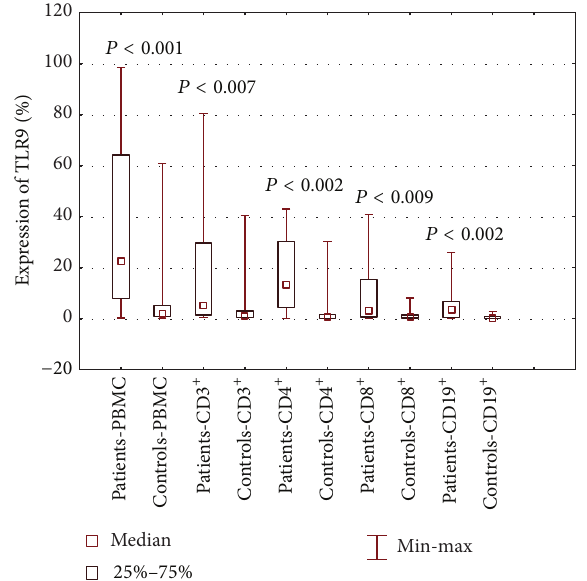
Figure 3: The percentage of PBMCs, lymphocytes B CD19 + , and lymphocytes T CD3 + , including CD4 + and CD8 + , expressing TLR3 in patients with SLE and healthy controls.